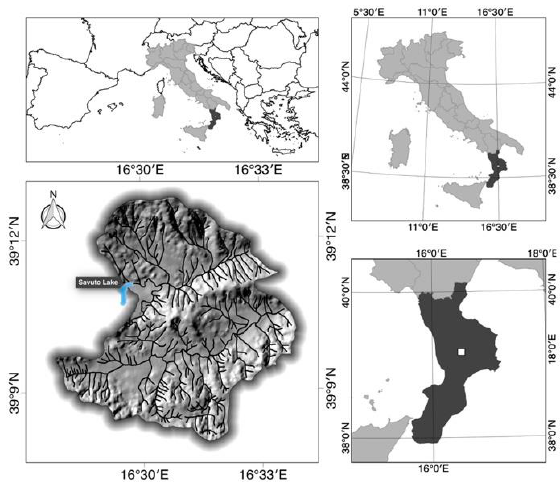
Figure 6. Location of the analyzed catchment area.